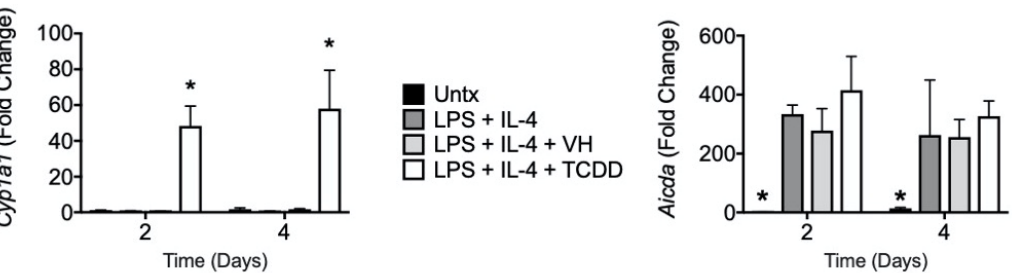
Figure 14. Effect of TCDD on gene expression. SPLC were treated with VH (0.01% DMSO) or TCDD